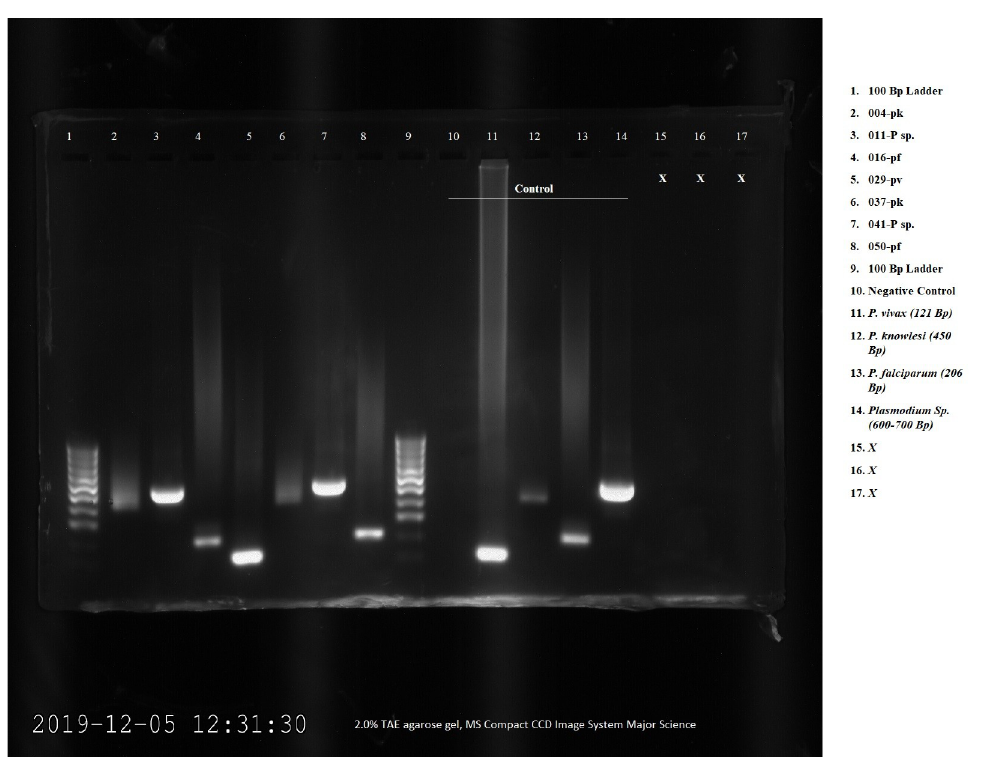
Fig 12. Malaria parasites species detected in An . balabacensis mosquito.